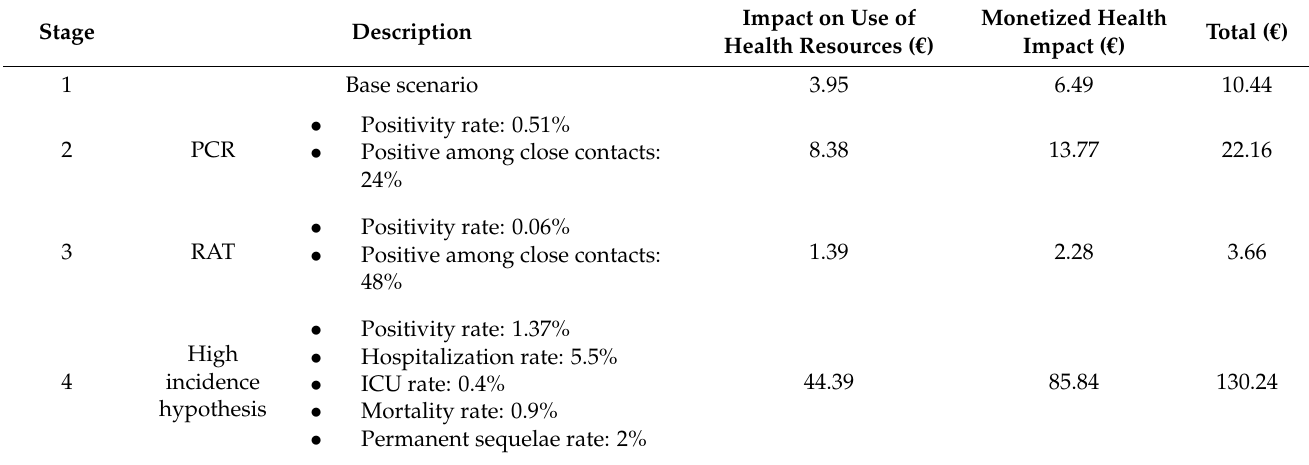
Table 3. Summary of the social savings of the screening policy ( € /test